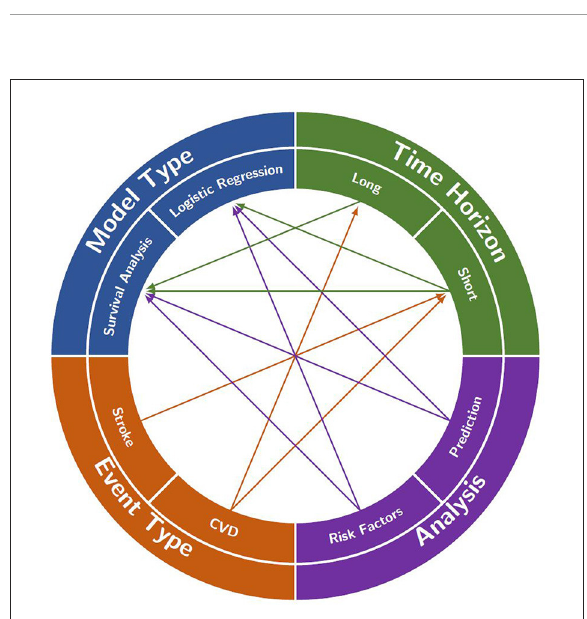
FIGURE2 A visualization of the interconnections between analysis focus, event type, time horizon and model type that are often found in the literature. Each of the four characteristics is split into two main decisions to be made when creating a model (e.g., long- or short-time horizon). A decision in each category will often help to decide on one of the other categories (e.g., deciding